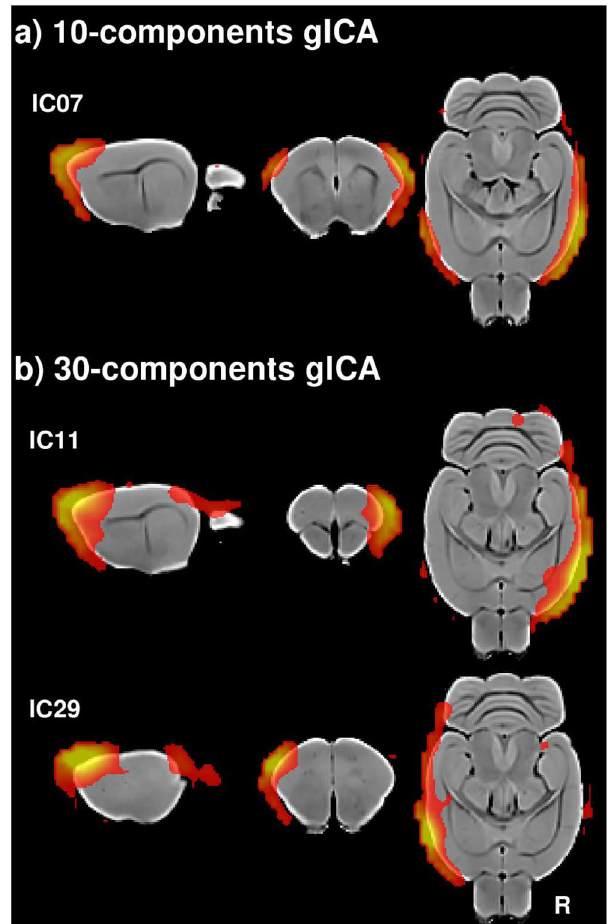
Figure 3. Artifactual components. ( a ) Ten components gICA. ( b ) Thirty components